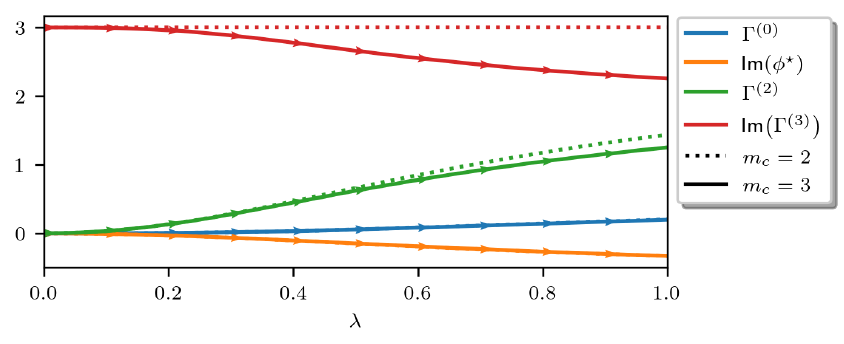
Figure 1: FRG flow of the vertex functions at k = 3 for cutoff function f λ ( ω ) = λ in the quantum case. Full lines show m